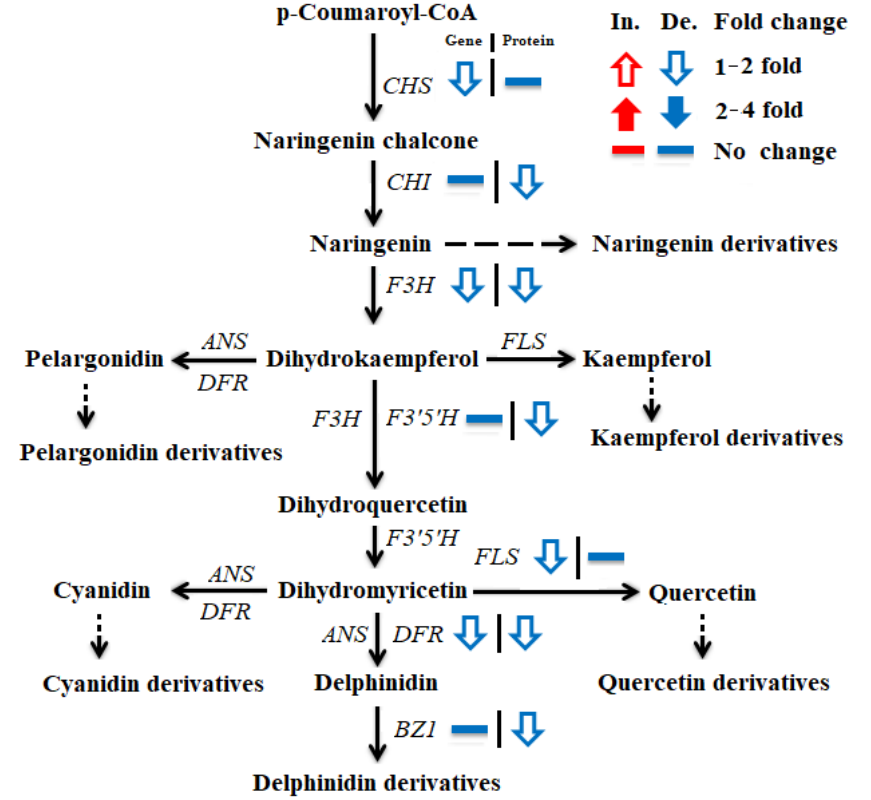
Figure 7. Comparative analysis between the aluminum-stressed and normal conditions of the expression levels for genes involved in the anthocyanin biosynthesis pathway.